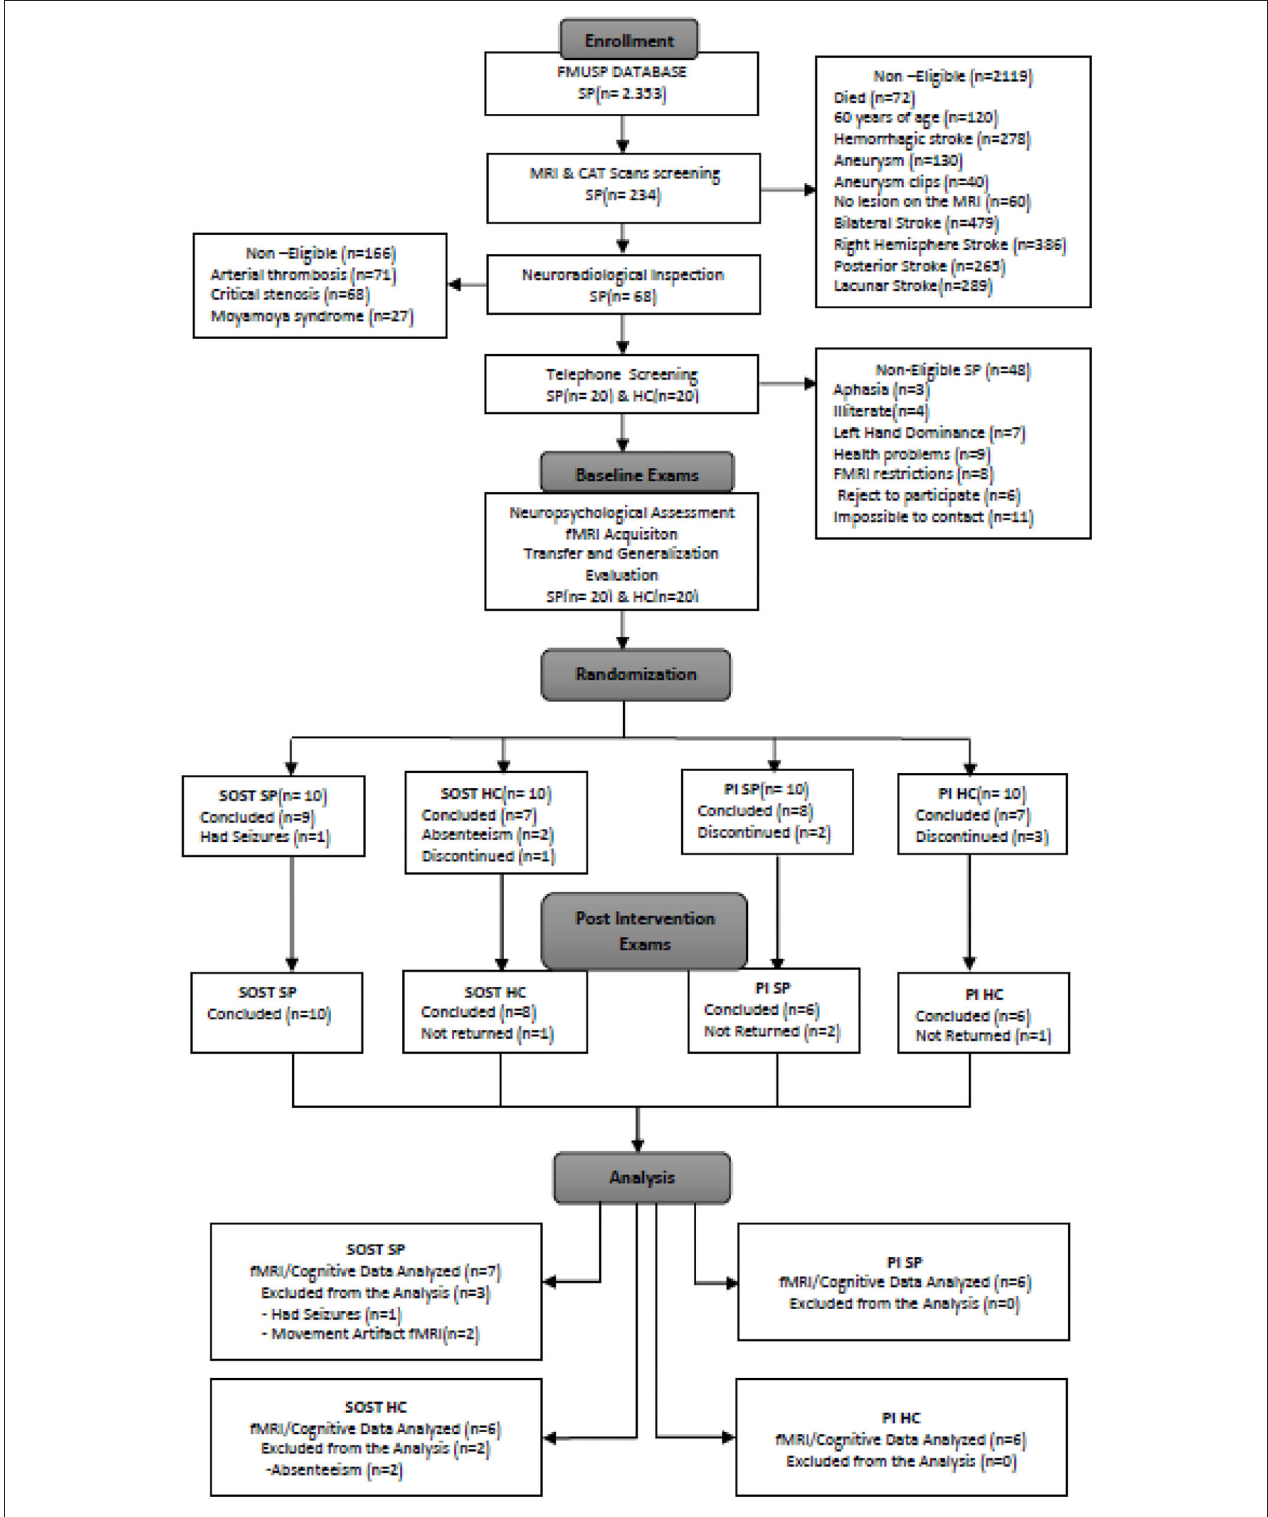
FIGURE 2 | CONSORT flowchart of the recruitment and selection of the study participants. SP, Stroke patients; HC, Healthy Controls; fMRI, Functional Magnetic Resonance Imaging; SOST, Semantic Organization Strategy Training; PI, Psychoeducational Intervention.